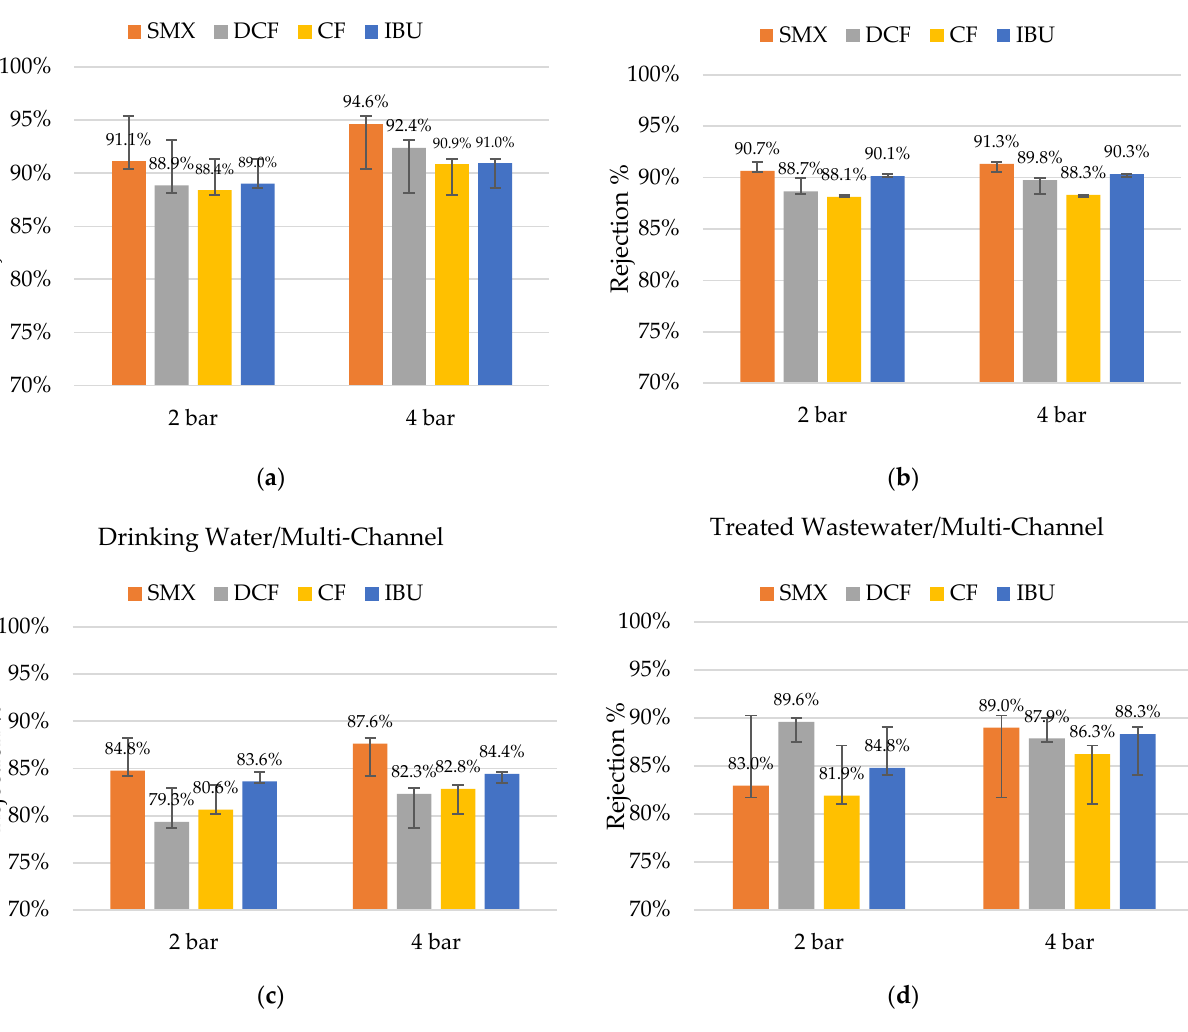
Figure 4. Rejection percentages of sulfamethoxazole (SMX), diclofenac (DCF), clofibric acid (CF), and ibuprofen (IBU), with pharmaceuticals spiking under different TMPs ( a ) drinking water with single-channel hybrid membrane (n = 3); ( b ) treated wastewater with single-channel hybrid membrane (n = 5 – 6); ( c ) drinking water with multi-channel hybrid membrane (n = 3); and ( d ) treated wastewater with multi-channel hybrid membrane (n = 2).